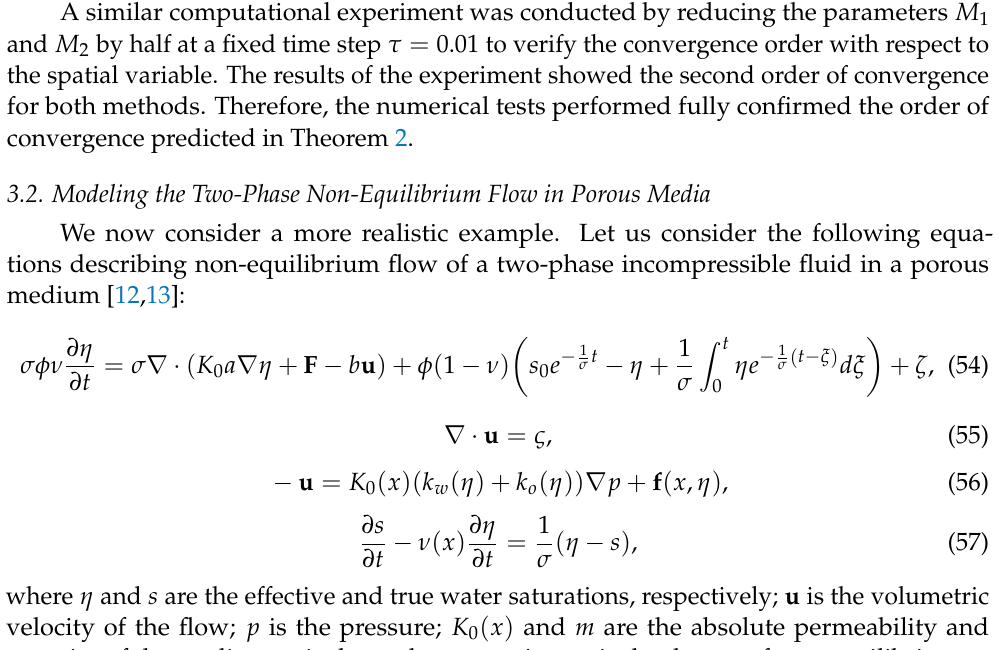
Table 1. Convergence analysis for η h with respect to the temporal variable conducted with a fixed spatial discretization parameter, h ≈ 0.004714. Our Method Method in [12] τ L 2 -Error Order L 2 -Error Order 1/10 9.708875 × 10 − 5 - 6.239779 × 10 − 3 - 1/20 2.383227 × 10 − 5 2.03 2.324491 × 10 − 3 1.42 1/40 5.549547 × 10 − 6 2.10 1.69